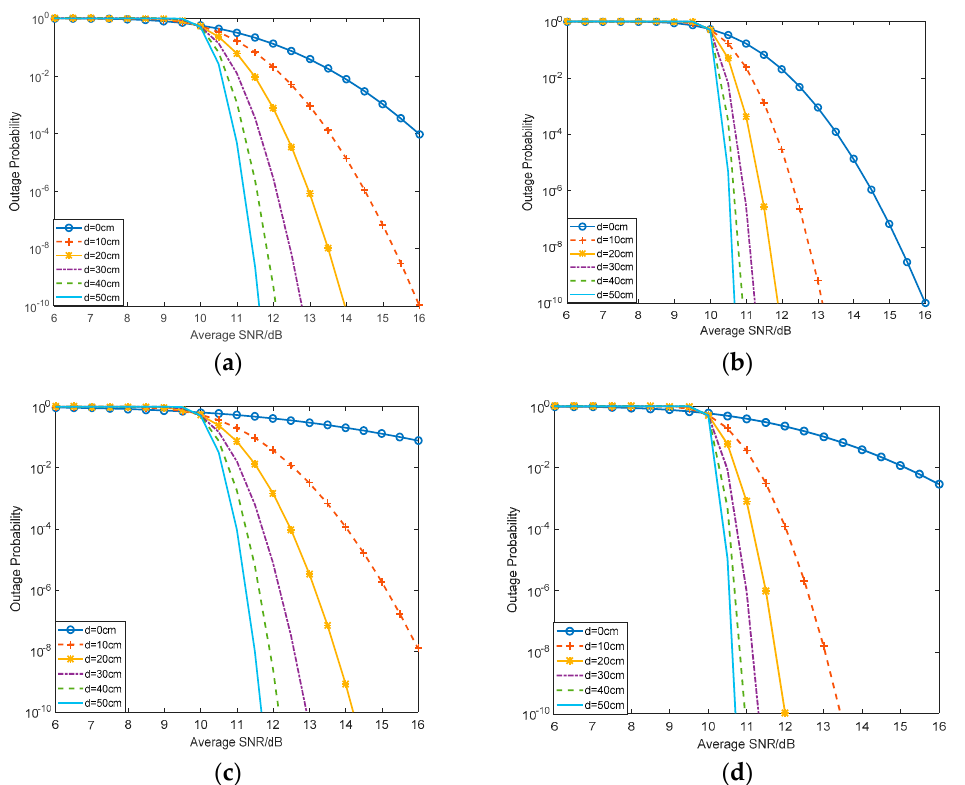
Figure 4. Performance of outage probability with different diameters, the turbulence conditions and zenith angles are: ( a ) A = 1.7 × 10 − 14 , w = 10, ζ = π /3; ( b ) A = 1.7 × 10 − 14 , w = 10, ζ = π /6; ( c ) A = 3.0 × 10 − 13 , w = 21, ζ = π /3; ( d ) A = 3.0 × 10 − 13 , w = 21, ζ = π /6.